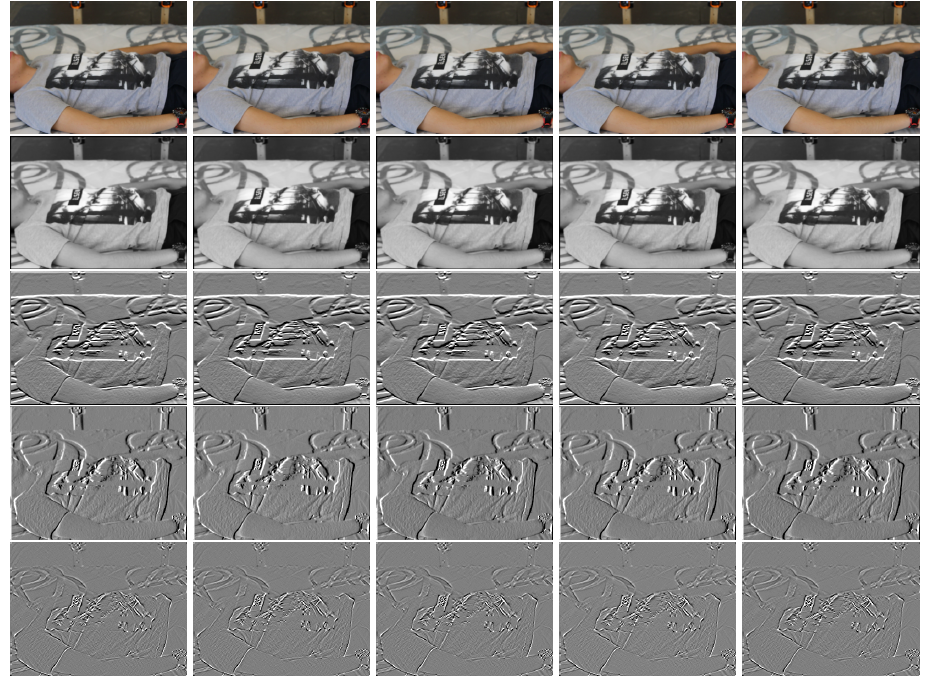
Figure 4. Hermite coefficients for several frames. Input frames (first row). L 00 coefficient (second row). L 01 and L 10 coefficients (third and fourth rows). L 11 coefficient (fifth